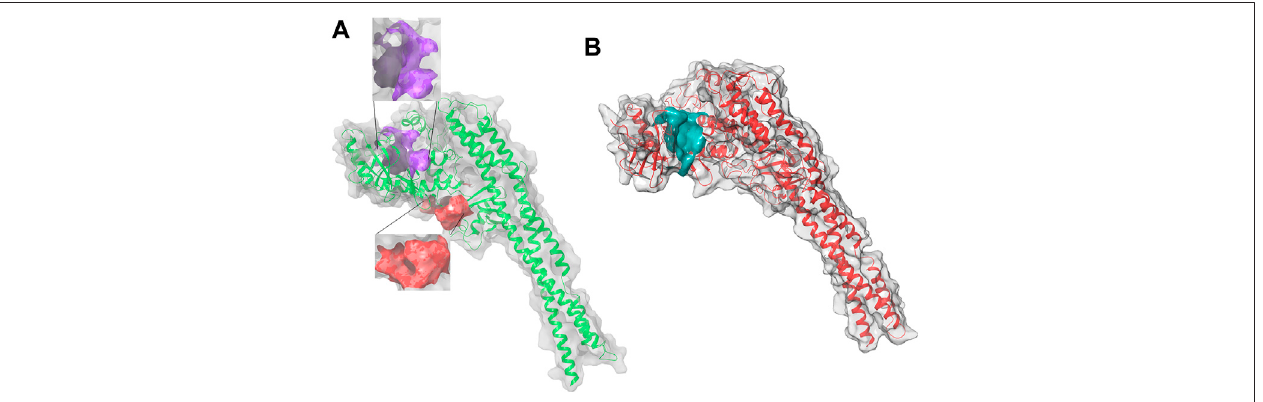
FIGURE2| 3DstructureofhIKKforms: (A) theinactiveform,ChainA,inpurpletheKDbindingpocket,inredtheallostericbindingsite; (B) theactiveform,ChainB, in cyan the KD binding pocket of the inactive Chain A with a volume of 551 Å. This pocket is surrounded by three α helixes (Arg118-Ser127, Leu265-Leu273, and Leu303-His313) of KD and a loop (Thr368-Leu386) between two β sheets of ULD. They suggested that small molecules binding in the pocket between KD and ULD probably interfere with the kinase function by disrupting the interaction between these two domains (Liu et al., 2018).